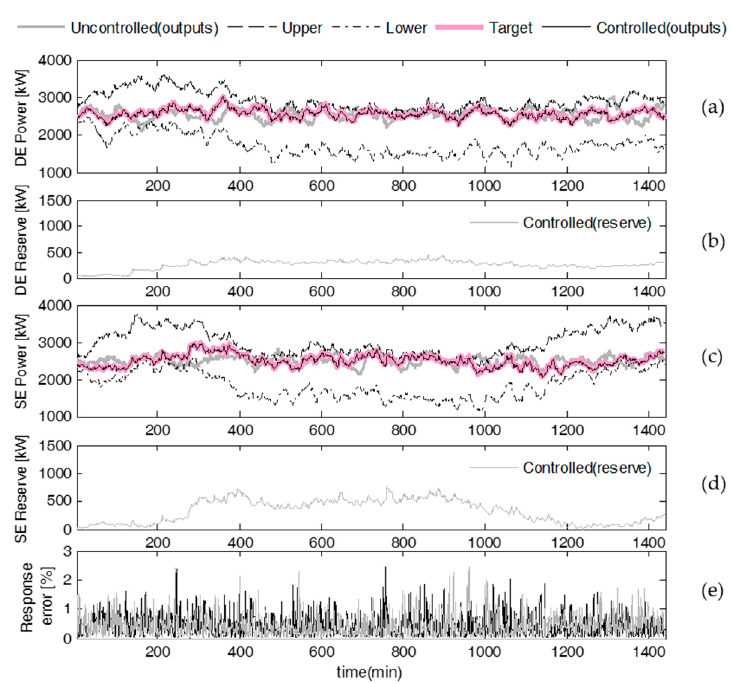
Figure 7. An EPP response and reserve provided by electrolyzers for the controlled and uncontrolled cases. ( a ) DE power consumptions; ( b ) DE-EPP reserve; ( c ) SE power consumptions; ( d ) SE-EPP reserve; and ( e ) the response error.